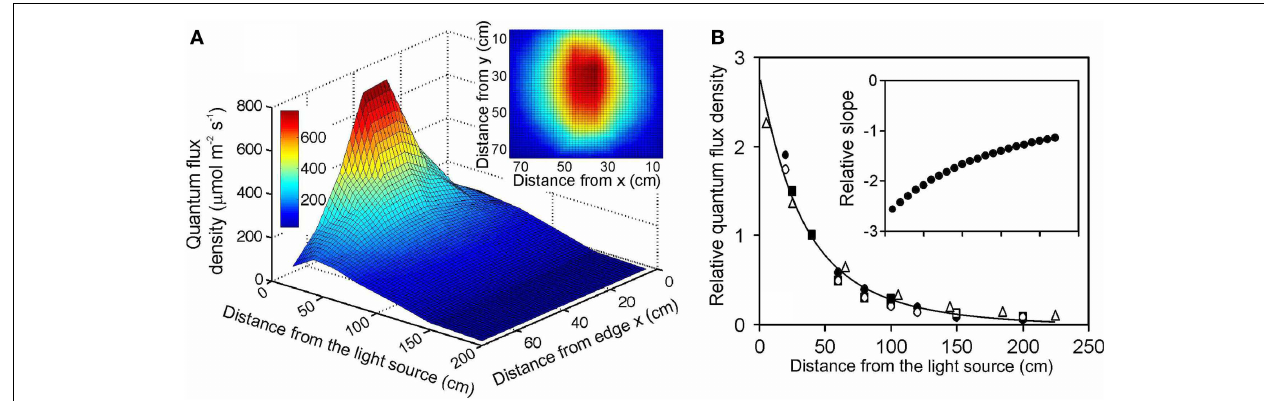
lamp distance using a black squared board (0.8m side length) with 64 regularly spaced measurement locations (altogether 7 heights, giving 448 measurements).The inset in (A) demonstrates a representative light field taken at 20cm from the lamp surface ( x and y correspond to the distance from the edge of the board).The relationship between lamp distance and light intensity in (B) was developed for averages measured for the central 30cm × 30cm area, and the data were normalized with respect to the measurements at 40cm from the luminaire surface. For comparison, data for a high pressure sodium lamp with a clear tubular bulb (Philips, Master SON-T PIA Plus 600W) from Buck-Sorlin et al. (2010) are also demonstrated (filled squares).The data in (B) were fitted by Eq. 12, and the inset demonstrates changes in relative slope (m − 1 ) calculated as ∆ y /( ¯ y ∆ x ) , where ∆ y and ∆ x are finite changes in the function value and argument, and ¯ y is the average function value over the given finite